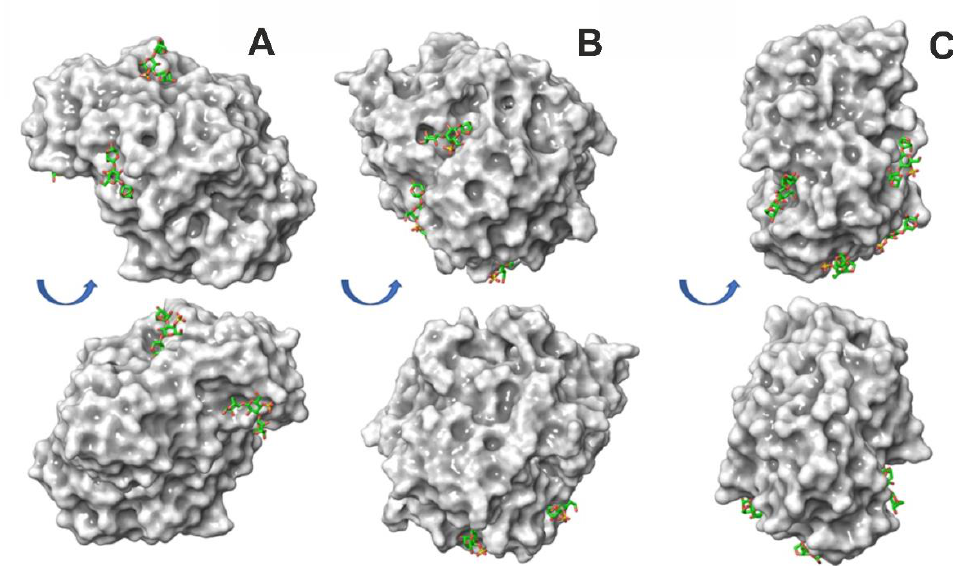
Figure 3. Most probable sites for κ -carrageenan binding with lipases from Candida rugosa ( A ), Mucor javanicus, ( B ) and Rhizomucor miehei ( C ). Proteins are shown in the surface representation and ligands in the stick representation.